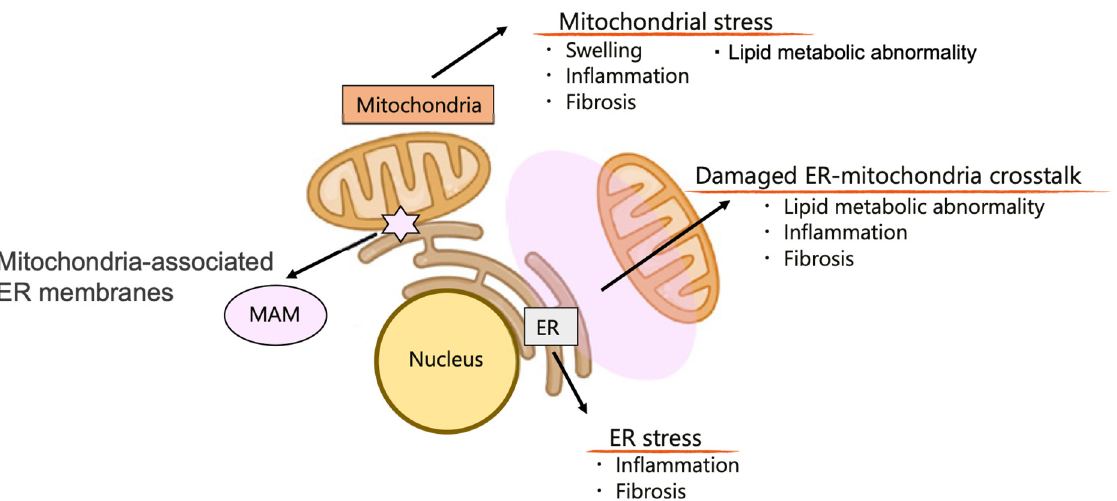
Figure 1. Organelle stress and organelle crosstalk link to lipid metabolic abnormality in the kidney. Omics-based research highlights the importance of metabolic homeostasis in cellular function and subsequent organ function. The metabolic abnormality is caused by organelle dysfunction, such as mitochondrial stress and endoplasmic reticulum (ER) stress, which lead to the disease phenotypes. In the kidney, organelle stress in tubular cells is a risk factor for inflammation and fibrosis mediated by mitochondrial lipid metabolic abnormality (lipotoxicity). Further, interorganelle communication, such as ER-mitochondrial crosstalk or organelle contact site (mitochondria-associated ER membranes: MAM), plays an important role in maintaining organelle homeostasis. Cited by [39] with modification.